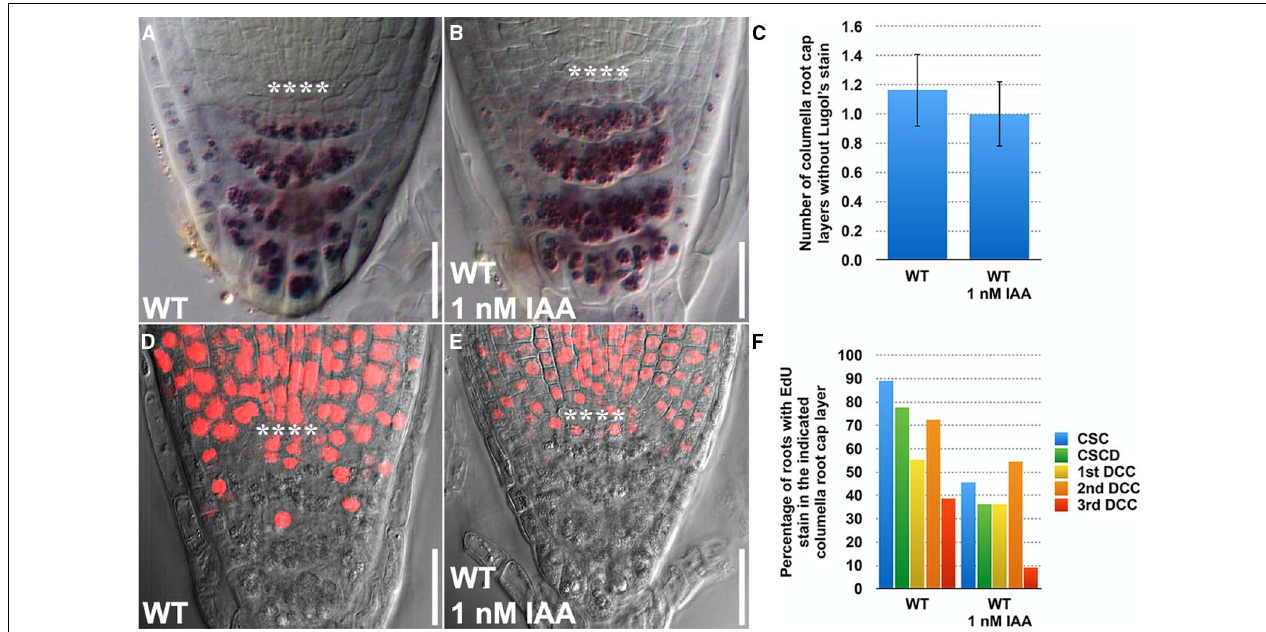
FIGURE 3 | EdU and Lugol’s staining can be combined and jointly used to investigate the effects of exogenously applied auxin on stem cell homeostasis in the Arabidopsis root. (A) Lugol’s staining of WT ( n = 14). (B) Lugol’s staining of WT treated with 1 nM IAA for 24 h ( n = 13). (C) Quantification of the number of layers of unstained columella root cap cells. (D) EdU staining of WT treated with 10 m M EdU for 24 h ( n = 18). (E) EdU staining of WT treated with 10 m M EdU and 1 nM IAA for 24 h ( n = 13).